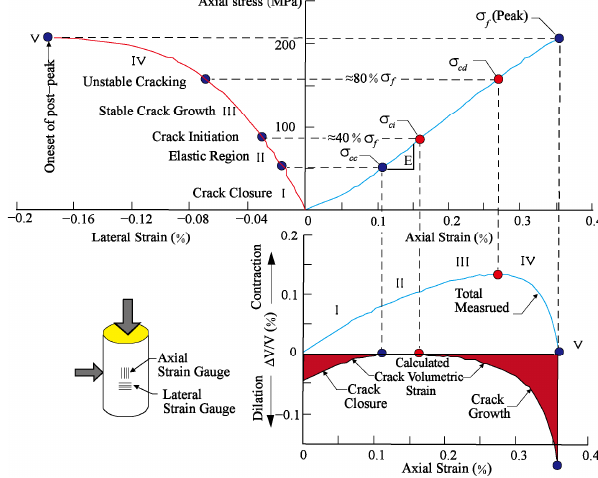
Figure 5. Crack volumetric strain model [21].